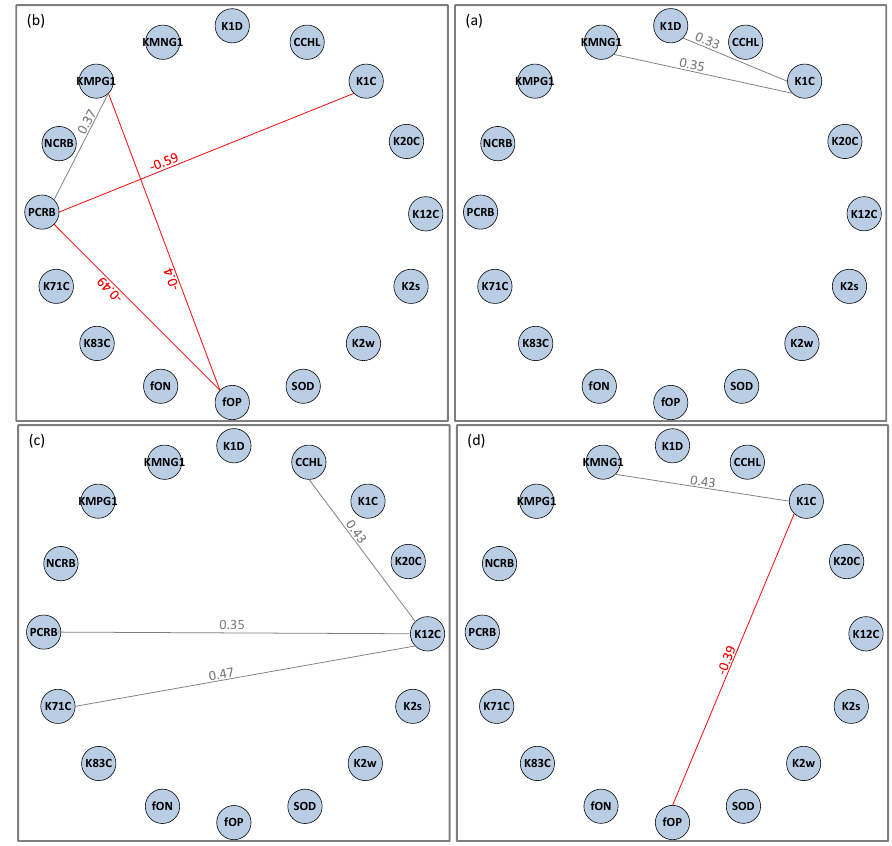
Figure 4. Nutrient and light limitations for the best performing simulation. ( a ) uSSR at Medicine Hat;